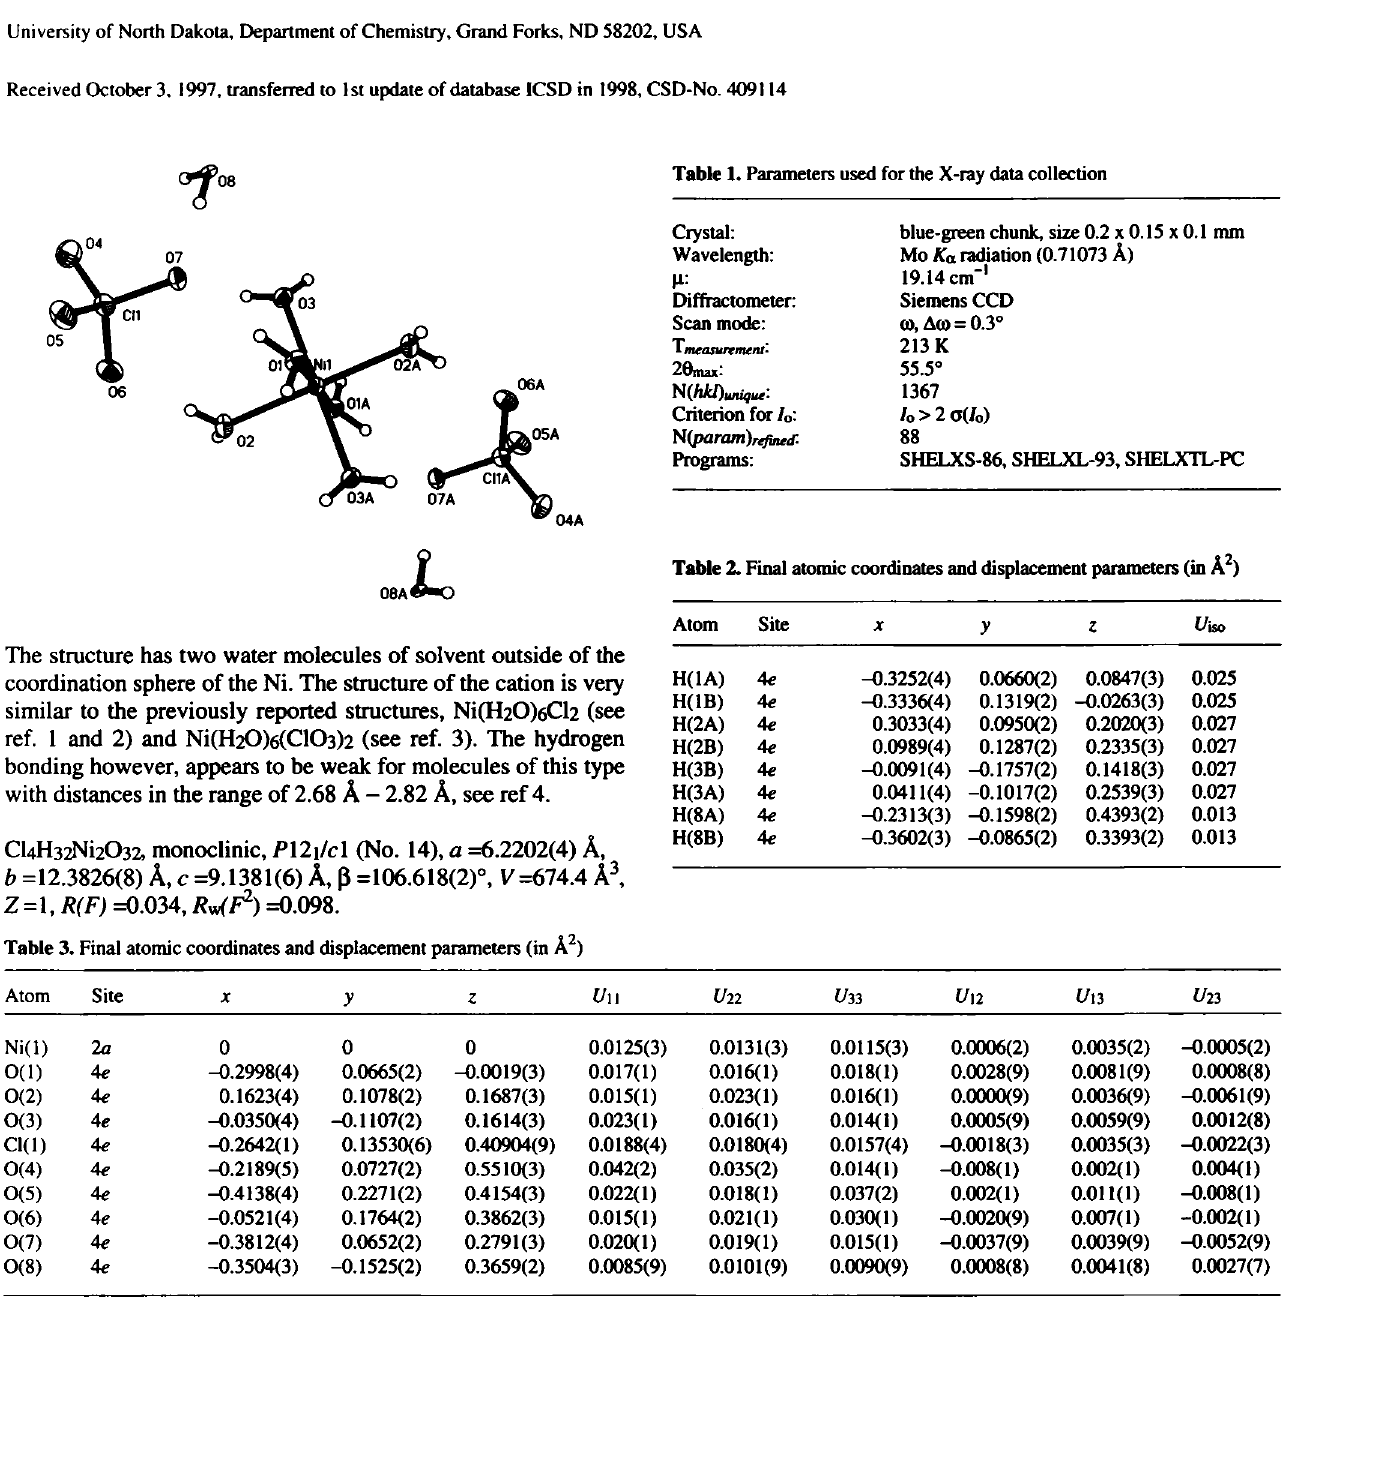
Table 2. Final atomic coordinates and displacement parameters (in